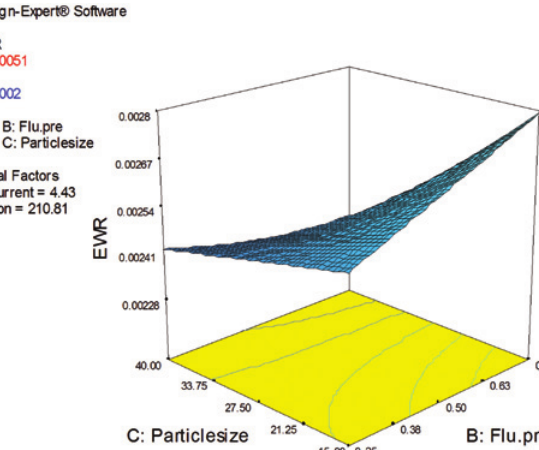
Figure 10 Interactive effect of flushing pressure and particle size on SR.